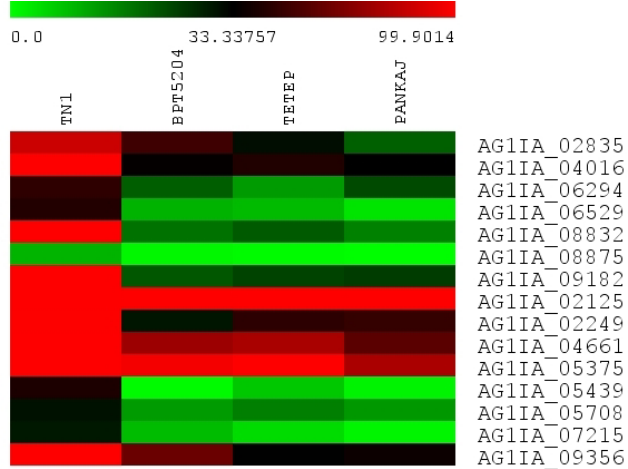
Figure 4. Heat map showing the expression of selected R. solani genes encoding carbohydrate-active enzymes. These genes showed very high expression in the most susceptible rice cultivar TN1. The values shown in bars at the top indicate FPKM.